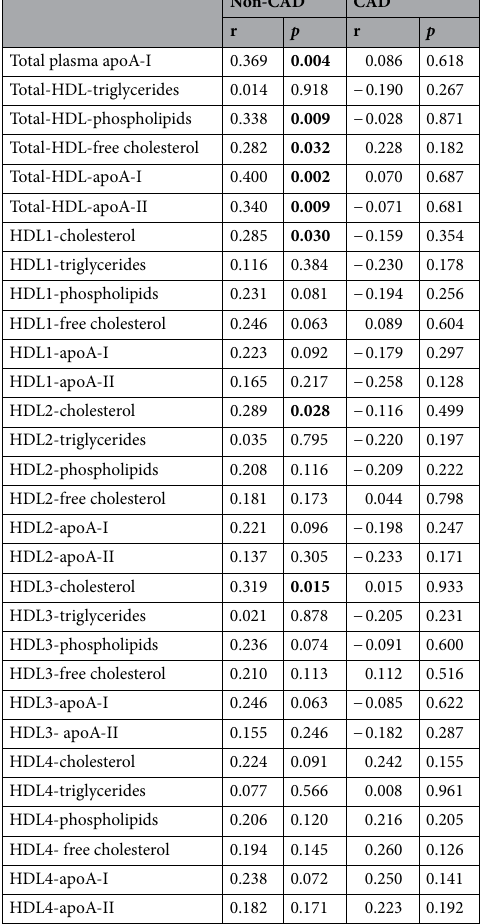
Table 2. Pearson’s correlation analysis between cholesterol efflux capacity and NMR-determined total plasma apolipoprotein A-I-rich lipoprotein and HDL-related lipoproteins in the non-CAD (n = 61) group and the CAD (n = 36) group. CEC, cholesterol efflux capacity; NMR, nuclear magnetic resonance; HDL, high-density lipoprotein; CAD, coronary artery disease; ApoA-I, apolipoprotein A-I; ApoA-II, apolipoprotein A-II. Boldface type emphasizes significant